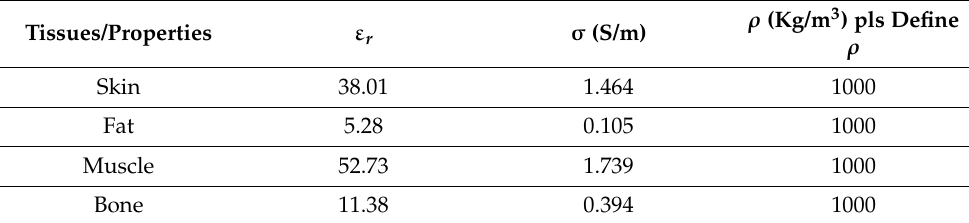
Table 6. The average tissue characteristics of human body parts at 2.4 GHz [77].